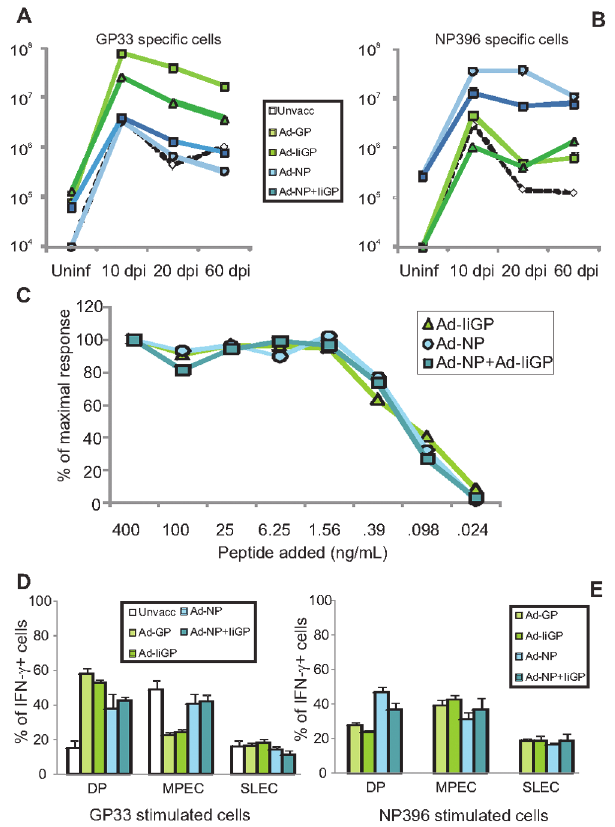
Fig 3. Numbers and phenotypes of memory CD8+ T cells. a) Numbers of GP33 specific CD8+ T cells from the mice described in Fig. 2 were plotted as a function of time. b) Numbers of NP396 specific CD8+ T cells from the mice described in Fig. 2 were plotted as a function of time. c) Pools of cells (4 mice per group) from the mice shown in Fig. 2e-f were stimulated with decreasing amounts of NP396. Results are depicted as the percentages of the response obtained at the highest peptide dose. Cells from similarly treated mice were also stimulated with GP33 or NP396 peptide, respectively, and the percentages of the CD8+ T cells producing interferon- γ that also expressed certain combinations of CD127 and KLRG-1 are shown, CD127+/KLRG1+ (DP), CD127+/KLRG1- (MPEC) and CD127-/KLRG1+ (SLEC)). d ) Mice infected 60 days previously stimulated with GP33, e) mice infected 60 days previously stimulated with NP396 epitopes. Shown are mean +SEM of 4 mice per